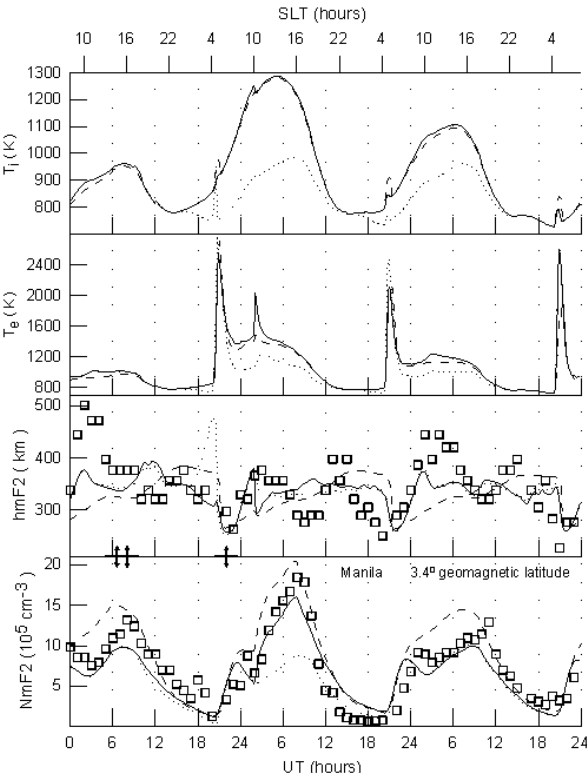
Fig. 7. From bottom to top, observed (squares) and calculated (lines) of NmF 2, hmF 2, electron temperatures and O + ion tem- peratures at the F 2-region main peak altitude above the Okinawa ionosonde station during 25–27 August 1987. SLT is the solar local time at the Okinawa ionosonde station. The start times of the sudden commencement (06:58 UT on 25 August), main phase (08:00 UT on 25 August) and recovery phase (22:00 UT on 25 August) of the geomagnetic storm are indicated by the arrows. The curves are the same as in Fig.